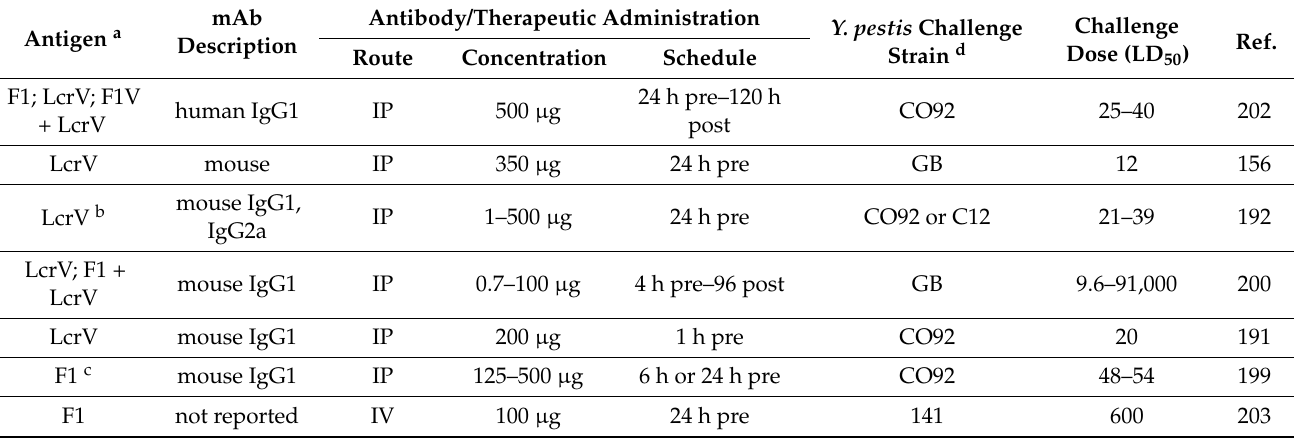
Table 1. Monoclonal antibodies shown to protect mice in bubonic plague models (subcutaneous challenge with bacteria). mAb Antigen a